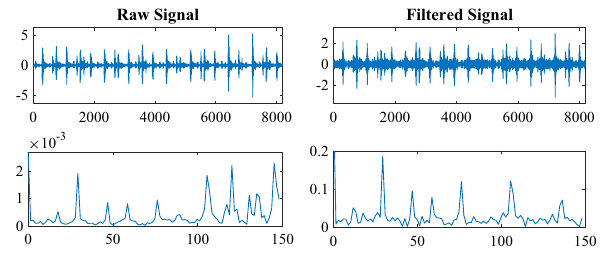
Figure 2. Raw signal and filtered